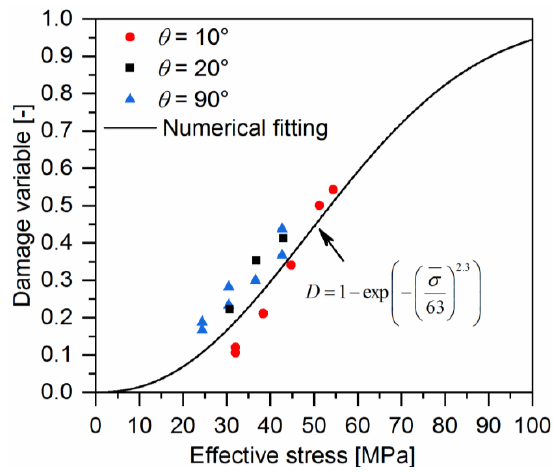
Figure 13. The relationship between the damage variable and the effective stress of a quasi-UD E-glass/polypropylene composite.